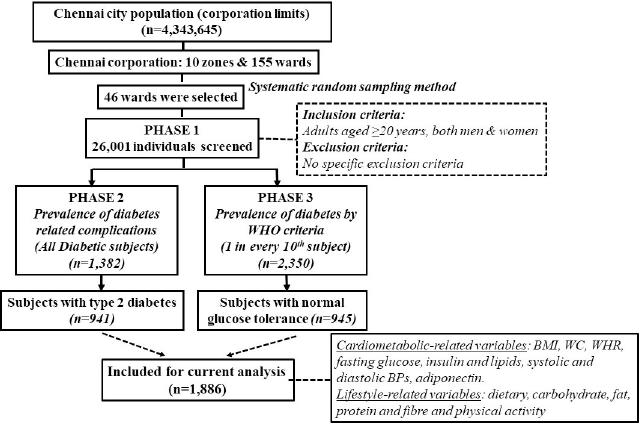
Fig 1. Flow diagram describing the selection of study participants. The Chennai Urban Rural Epidemiology Study (CURES) is a large ongoing epidemiological study on a representative population of Chennai. Briefly, the city of Chennai is divided into 155 corporation wards representing a socioeconomically diverse group. In Phase 1 of CURES, individuals from 46 corporation wards were screened by a systematic sampling technique. The sample distribution in each ward within these zones is based on the proportion of their population in that zone. A probabilistic proportionate sampling was adopted to select the number of individuals seen in each ward. Furthermore, within each ward, every third lane or road, following the right-hand rule, was surveyed. A total of 26,001 individuals aged � 20 years were screened. Phase 2 of CURES deals with studies on the prevalence of microvascular and macrovascular complications of diabetes in subjects with self-reported diabetes from Phase 1 of the study. In Phase 3 of CURES, every tenth subject recruited in Phase 1 (n = 2,600), was invited to the tertiary care centre for diabetes for an OGTT; known diabetic subjects had fasting and postprandial glucose tests. For the current article, analysis was computed in randomly selected 941 individuals with diabetes from Phase 2 and 945 individuals with normal glucose tolerance from Phase 3, totalling to 1,886